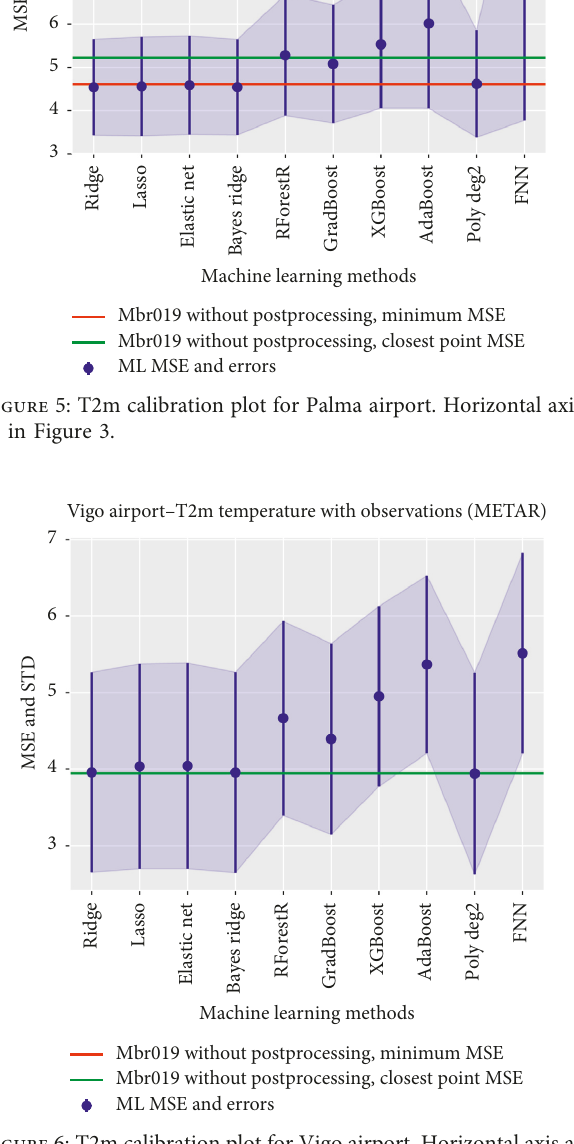
Figure 6: T2m calibration plot for Vigo airport. Horizontal axis as in Figure 3.